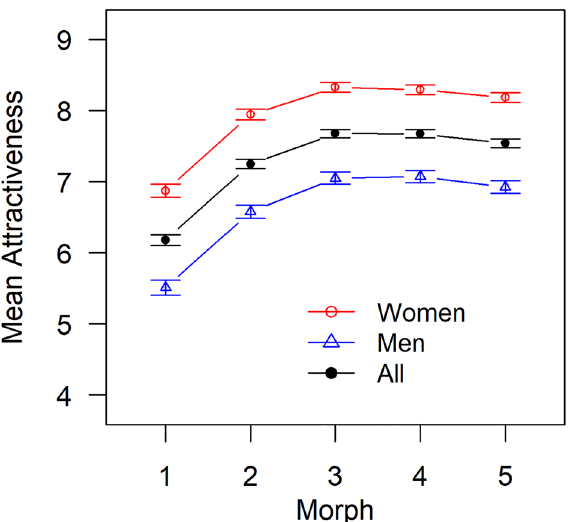
Figure 4. Mean attractiveness ratings of the five morphs in Study